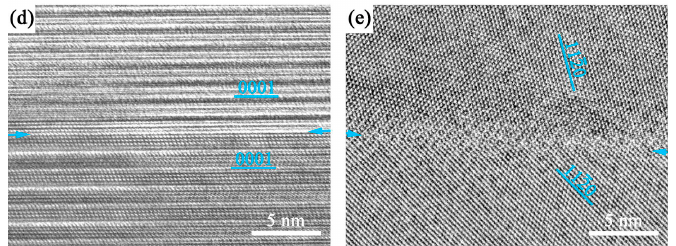
Figure 5. ( a ) Schematic diagram of tailored dense bulk nanolayered Nb 4 AlC 3 ceramic, showing the orderly stacking of grains whose c -axes are perpendicular to the textured top surface; ( b , c ) SEM micrographs of etched textured side and top surface; ( d , e ) High-resolution transmission electron microscope atomic images of grain boundaries (indicated by arrows) observed from the textured side and top surface directions [40].